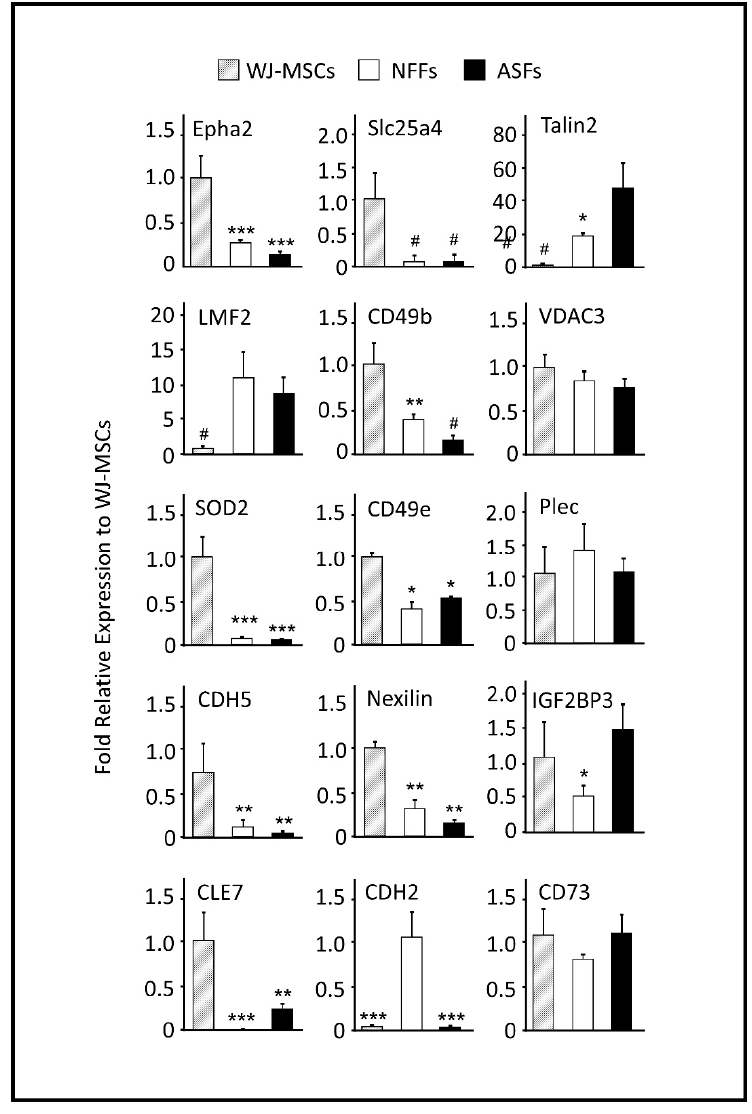
Figure 3. qRT-PCR analysis of 15 selected genes differentially expressed by WJ-MSCs, ASFs, and NFFs. Relative quantification was calculated by comparing gene expression levels in ASFs and NFFs with corresponding WJ-MSCs expression, which was set to 1 (control sample). Gene expression was initially normalized to the geometric mean for the housekeeping genes β -actin, Glyceraldehyde 3- phosphate dehydrogenase (GAPDH), and S18, as references. Data are presented as the means ± standard deviation of six qRT-PCR assays (technical duplicate of three biological samples). * p < 0.05, ** p < 0.01, and *** p < 0.001 are significant to the higher bar. # p < 0.01 is significant to all other bars. The expression levels of the integrin subunit integrin alpha-5 (ITGA5, CD49e), insulin-like growth factor 2 mRNA-binding protein 3 (IGF2BP3), the RNA transcription, translation and transport factor CLE7, the vascular-endothelial VE-cadherins (CDH5, CD144), and the actin-binding protein Nexilin were also analyzed. The mRNA quantifications by qRT-PCR results revealed that CD49e,